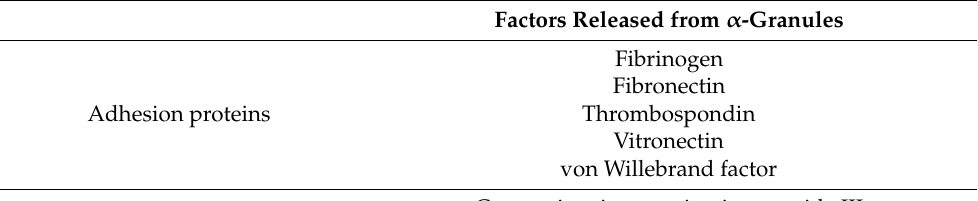
Table 1. Overview of factors released from platelet α -granules [15–20]. The α -granule degranulates upon activation of the platelet, which may occur in cases of stress, disease, or normal haemostatic function in formation of the platelet